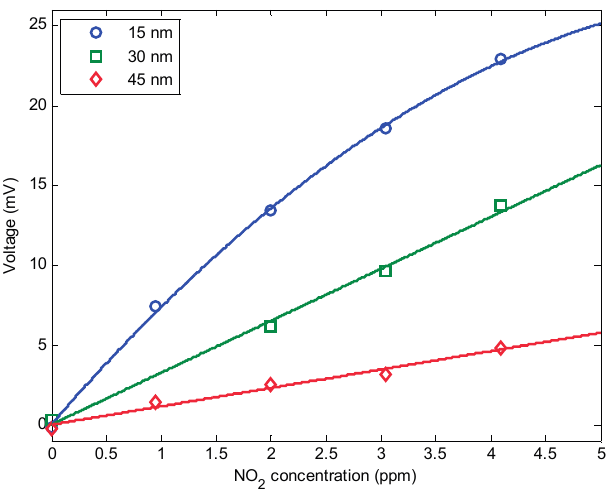
Figure 6. Calibration of the optical fiber sensors with NO 2